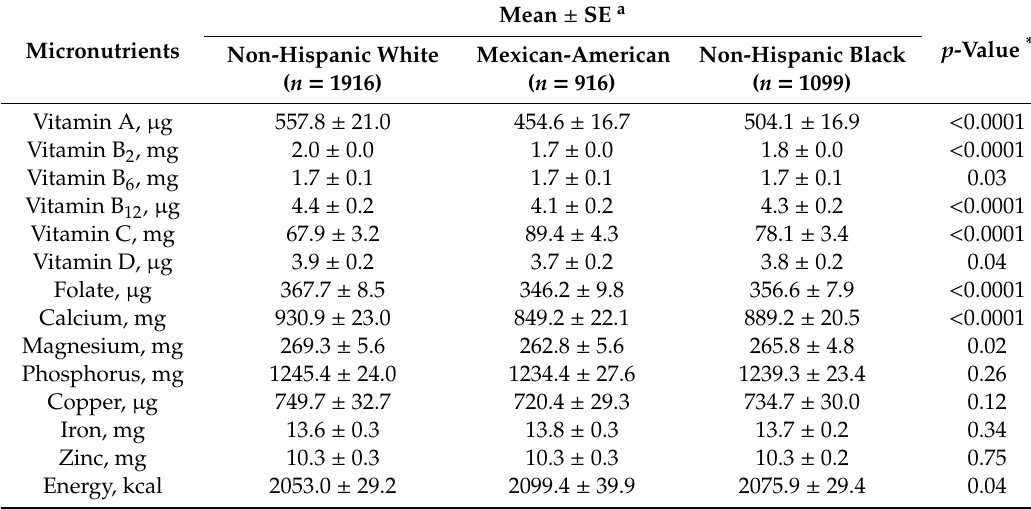
Table 2. Estimated daily usual micronutrient intakes from foods among women aged 19–39 years by racial / ethnic groups, NHANES 2003–2014 ( N = 3931).